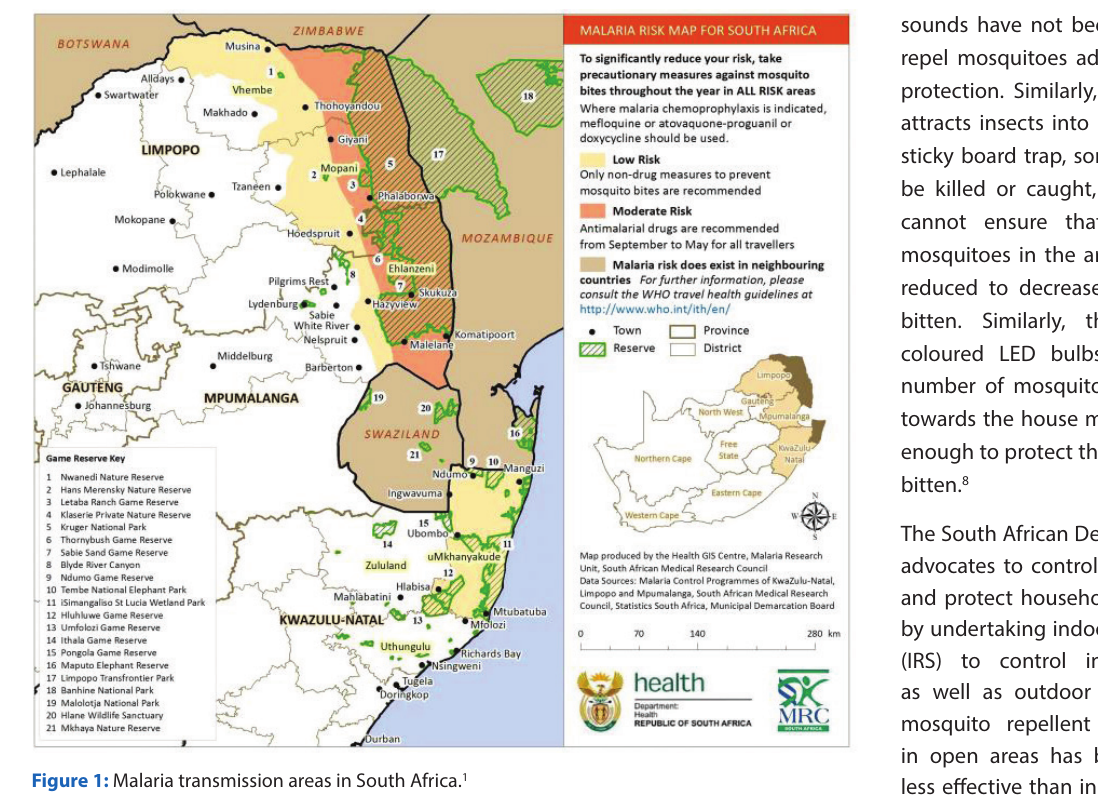
Figure 1: Malaria transmission areas in South Africa.